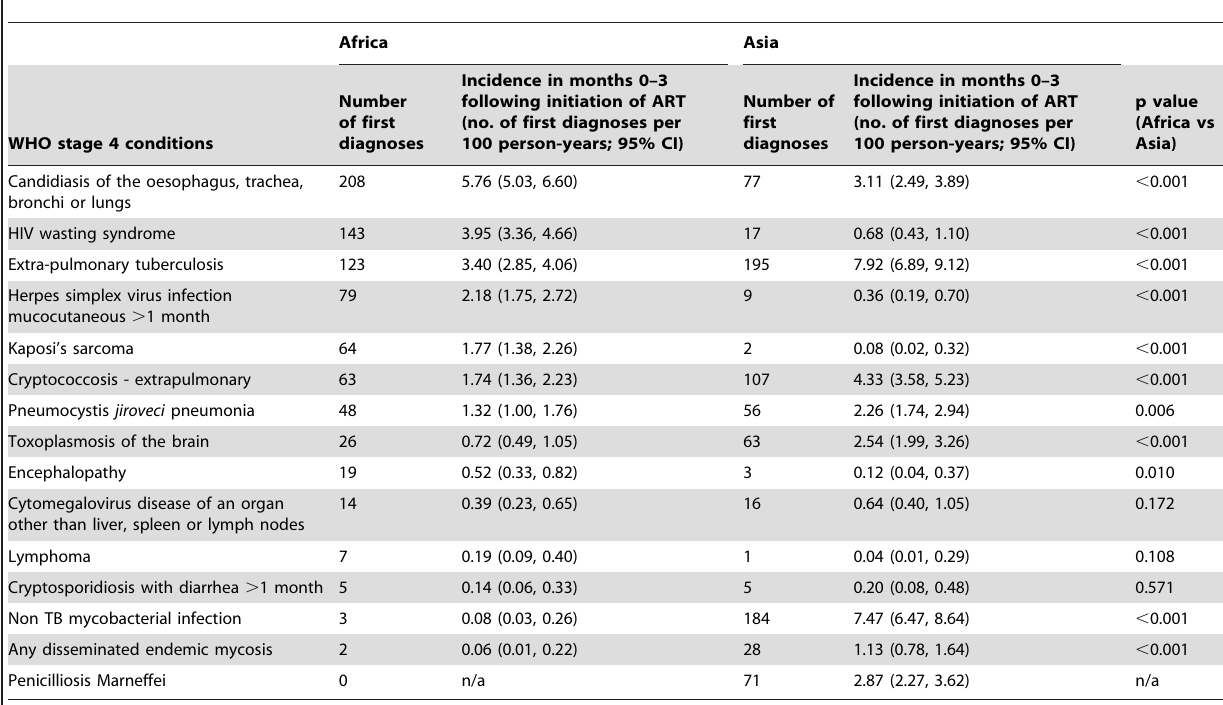
Table 5. Regional disease specific incidence of WHO stage 4 conditions in months 0–3 following ART initiation.